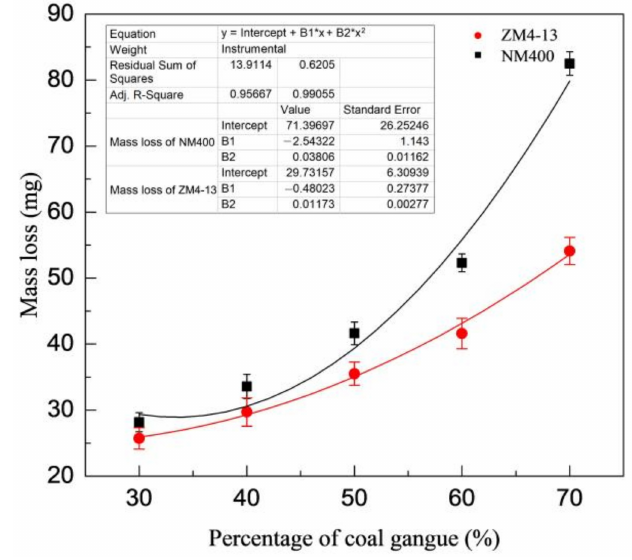
Figure 6. Change of the mass loss with the percentage of coal gangue.